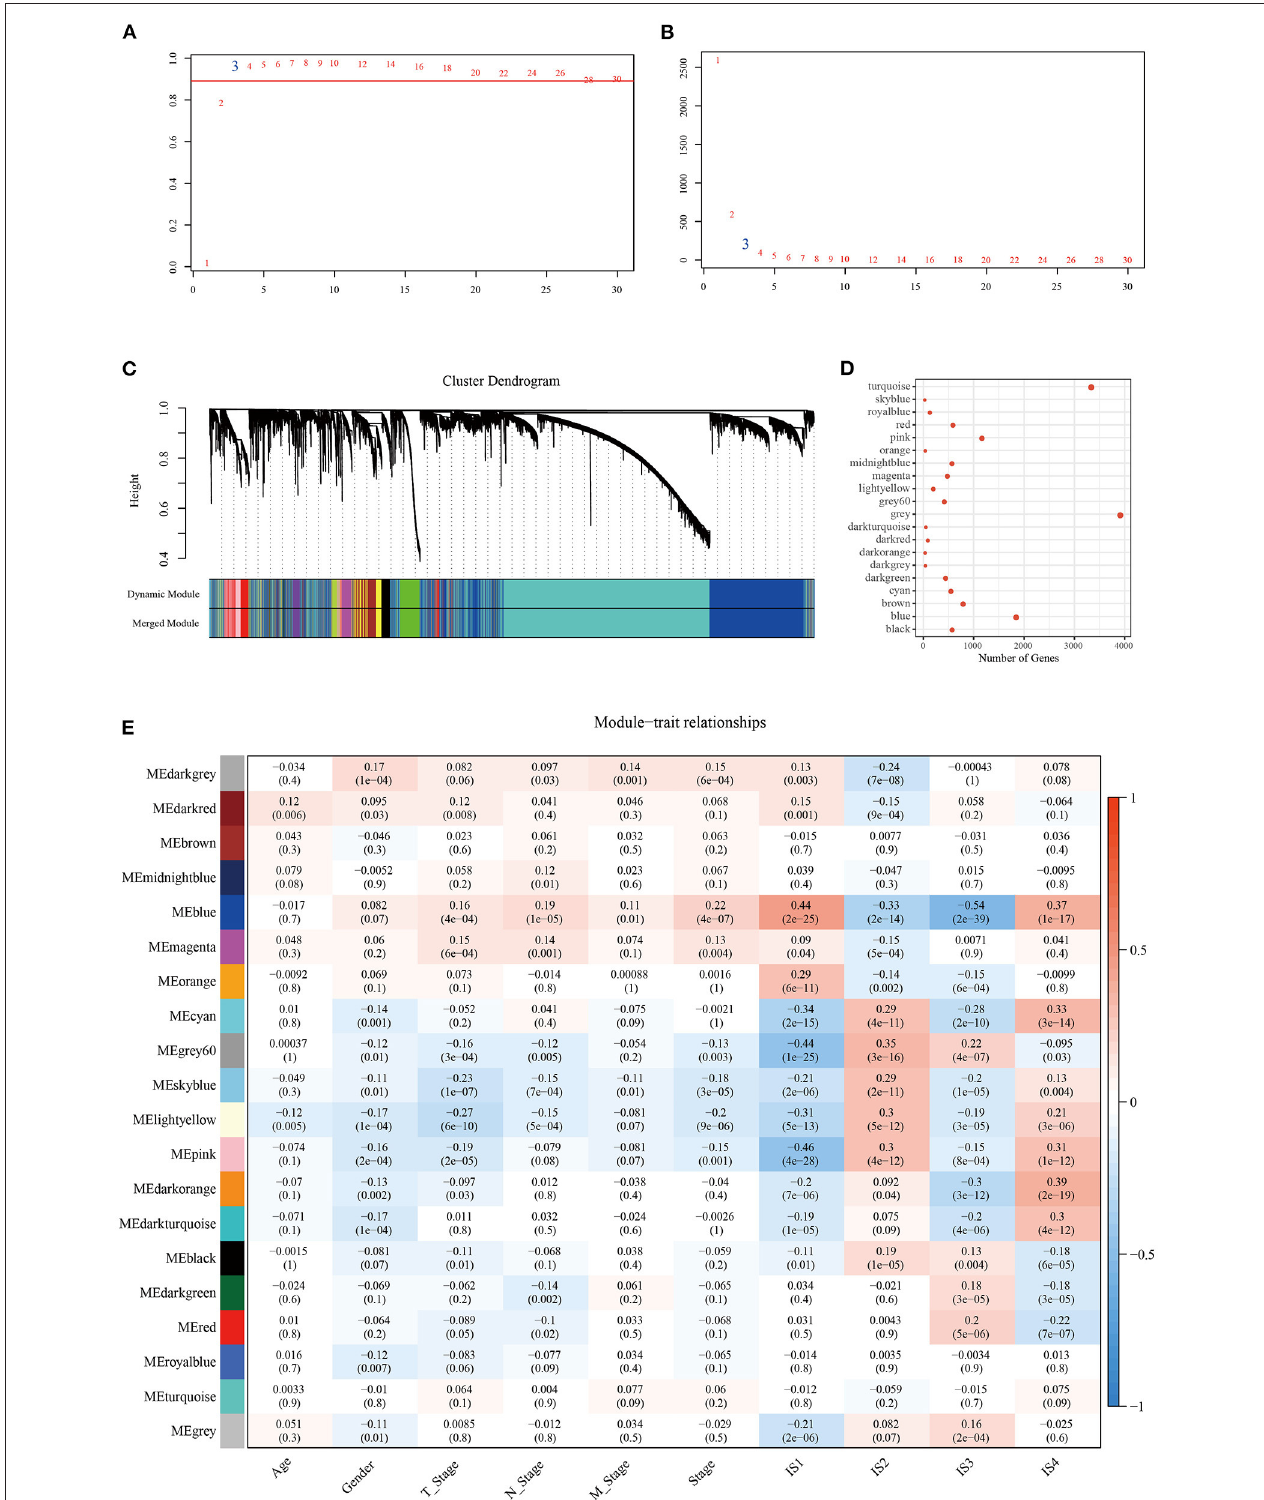
FIGURE 8 | Construction of LUAD co-expression module and identification of key modules. Analysis of (A) the scale-free fit index and (B) the mean connectivity for various soft-thresholding powers. (C) Clustering dendrogram of genes based on topological overlapping. (D) A transcript of each module. (E) Analysis of module-clinical trait relationships of